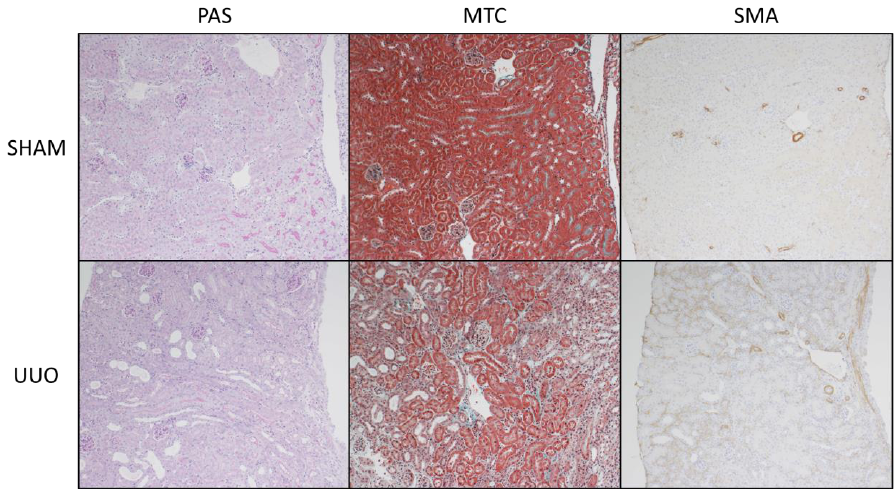
Figure 18 . Fstl1 Histology of sham and UUO mice. Periodic acid–Schiff (PAS) (left panels), Masson Trichrome (MTC) (middle panels), and alpha-Smooth Muscle Actin (SMA) (right panels) in sham-operated mice (upper panels) and mice subjected to UUO for 7 days (lower panels).